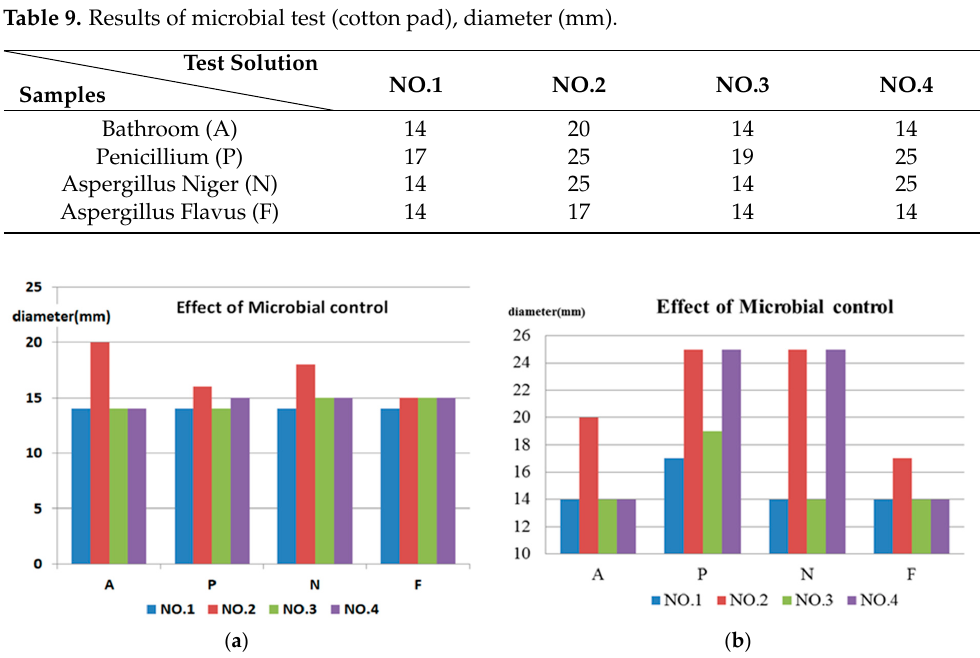
Figure 13. Effects of microbial control: ( a ) metal ring and ( b ) cotton pad. Table 8. Results of microbial test (metal ring), diameter (mm).